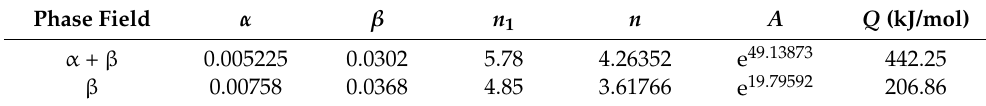
Table 3. Parameters for constitutive relations.